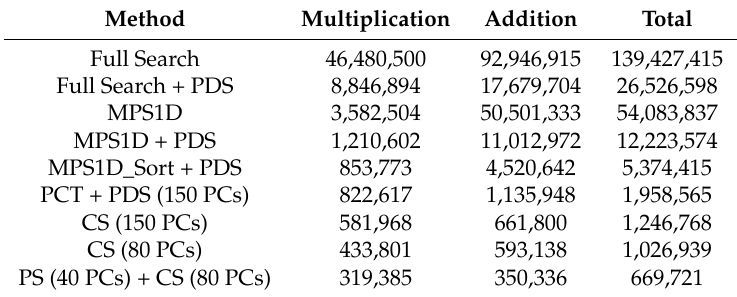
Table 6. Average number of multiplication and addition operations of each